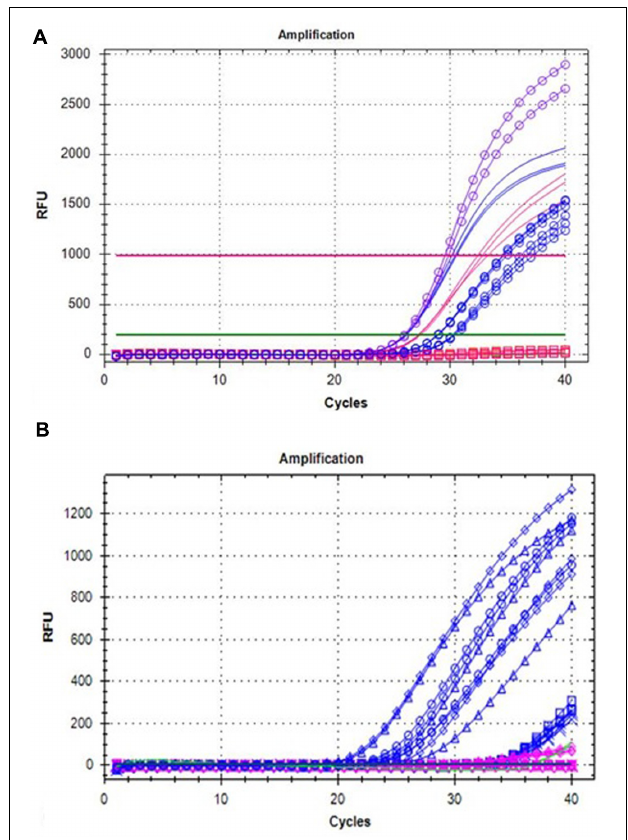
FIGURE 5 | (A) Probe analysis on genomic DNA samples of “Anne” (blue) and “Tulameen” (pink) for the 5 bp insertion (ans + 5 ). Probe assay on both genomic DNA (blue circles), ‘pCR TM 4-1840’ (violet circles) of “Anne” and genomic DNA, ‘pCR TM 4-1835’ (pink squares) of “Tulameen”. Genomic DNA samples amplified from “Anne” (blue lines) and “Tulameen” (pink lines) without probe in reaction mix. (B) Probe analysis on different fruit stages of “Anne” (blue) and “Tulameen” (pink) for the 5 bp insertion (ans + 5 ). Transcripts from different fruit stages of “Anne” exhibits fluorescent signals (blue) but none of the “Tulameen” fruit stage (pink) as indicated by the diamond (Stage 1), cross (Stage 2), triangle (Stage 3), sequence (Stage 4), and circle (Stage 5). NTC is indicated along the baseline